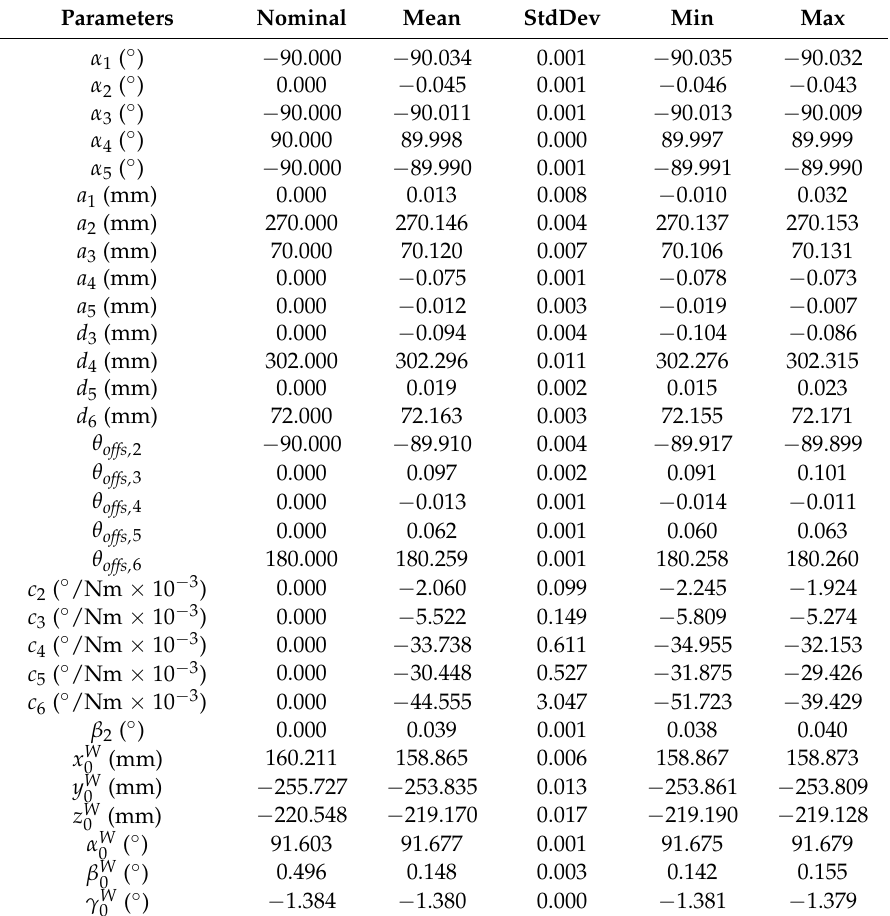
Table 7. Identified parameters from 30 optimized sets of 75